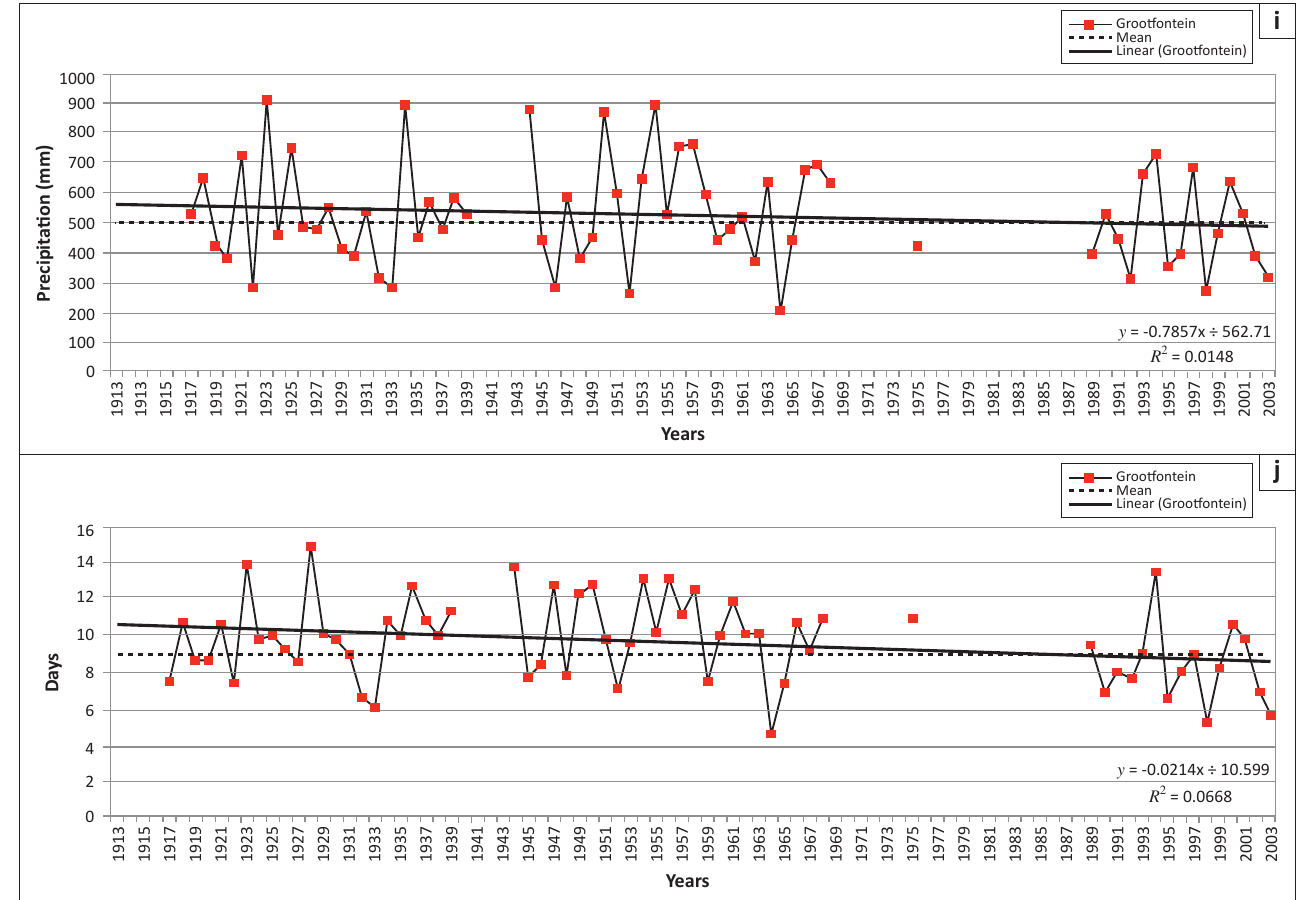
FIGURE 7 (Continues...): Ten climate change extreme precipitation indices for the Grootfontein rainfall station: (a) annual count of days when RR > 10 mm; (b) annual count of days when RR >= 20 mm; (c) annual total precipitation when RR > 95 th percentile of 1961–1990 daily rainfall; (d) annual total precipitation when RR > 99th percentile of 1961–1990 daily rainfall; (e) annual maximum 1–day precipitation; (f) annual maximum consecutive 5–day precipitation; (g) maximum number of consecutive wet days; (h) maximum number of consecutive dry days; (i) annual total precipitation from wet days and (j) average precipitation on wet days.